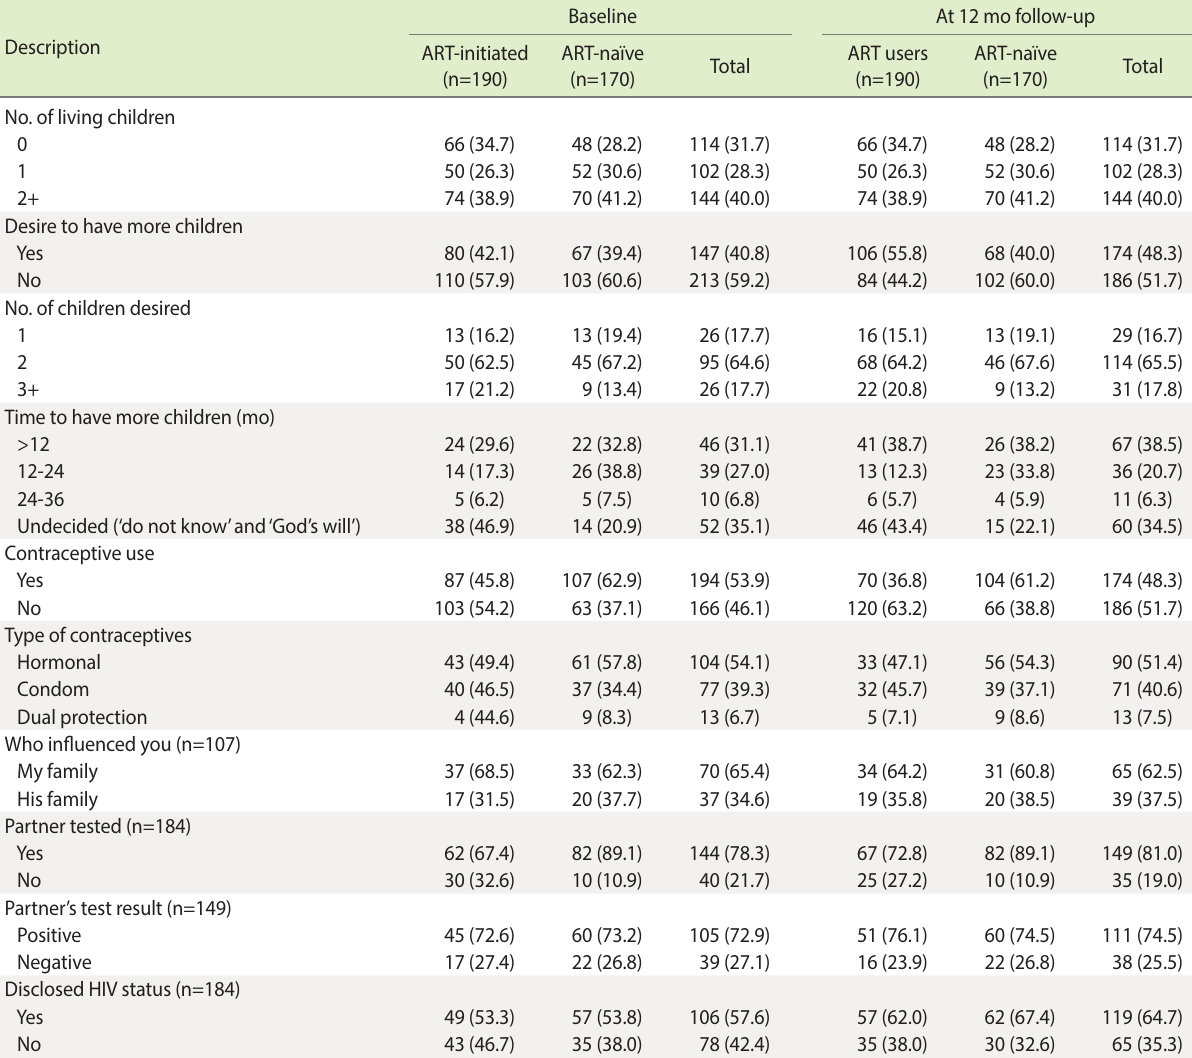
Table 2. Reproductive, clinical, and fertility intentions of HIV-positive women (baseline vs. 12-month follow-up) in Addis Ababa,